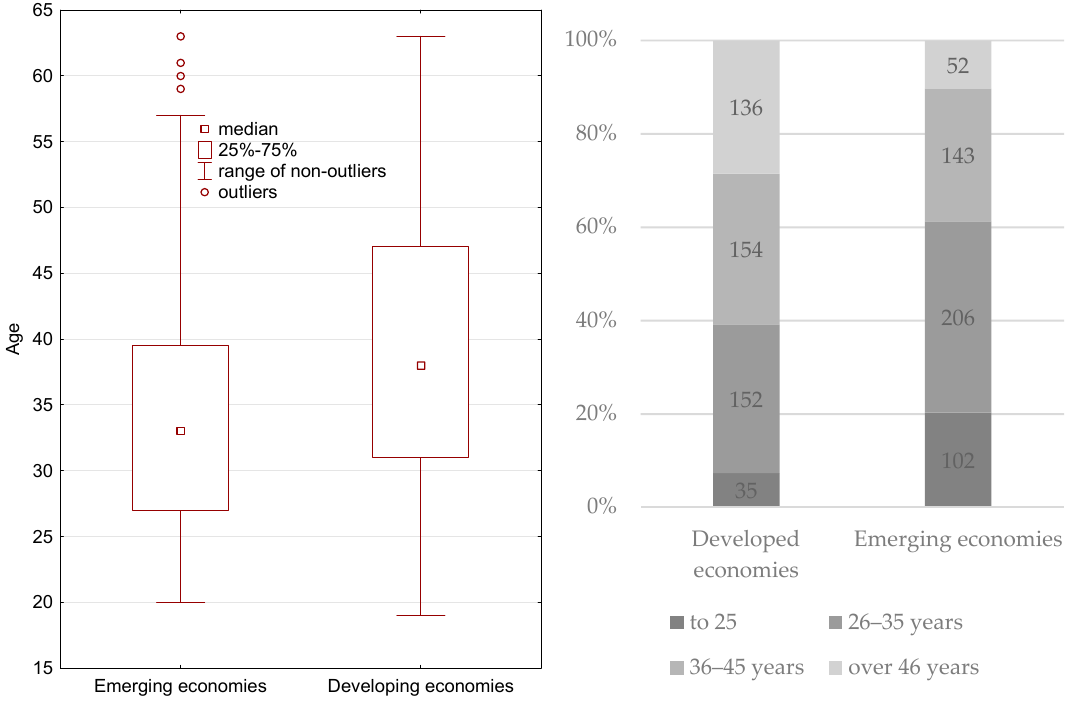
Figure 1. Age of respondents.